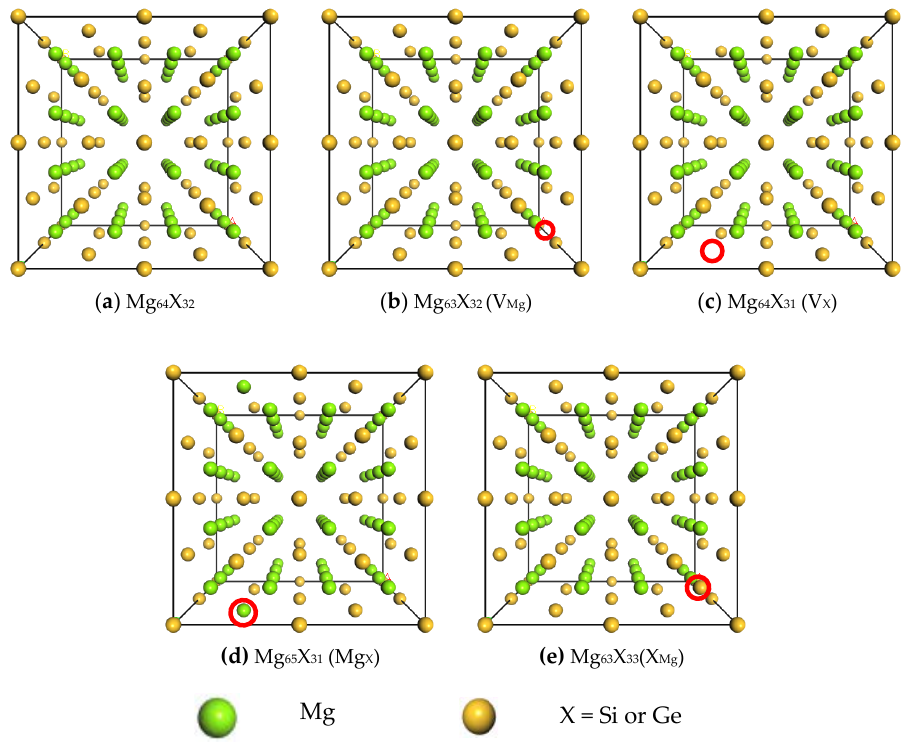
Figure 2. 2 × 2 × 2 supercell crystal structure of Mg 2 X (X = Si, Ge) with vacancy point defects or anti-site defects, ( a ) Mg 64 X 32 , ( b ) Mg 63 X 32 (V Mg ), ( c ) Mg 64 X 31 (V X ), ( d ) Mg 65 X 31 (Mg X ) and ( e ) Mg 63 X 33 (X Mg ). The red squares represent the position of the vacancy or anti-site defects.